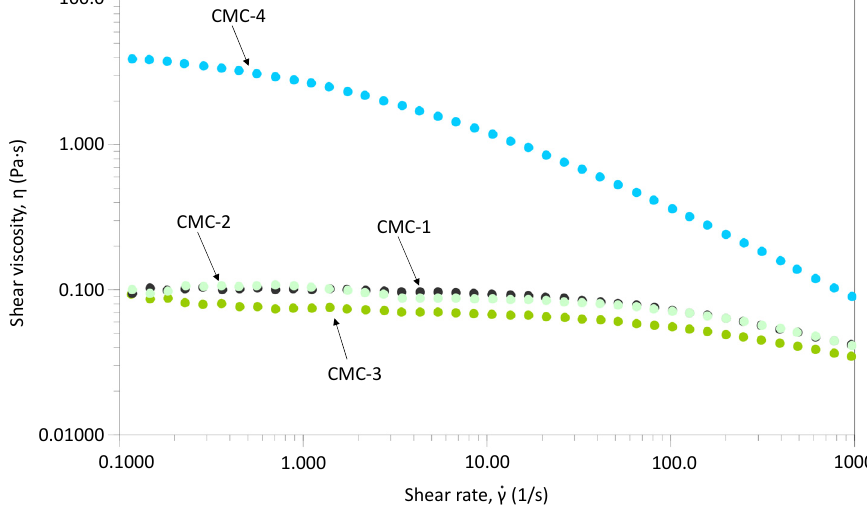
Figure 5. Shear viscosity plotted as a function of shear rate for variants of CMC.